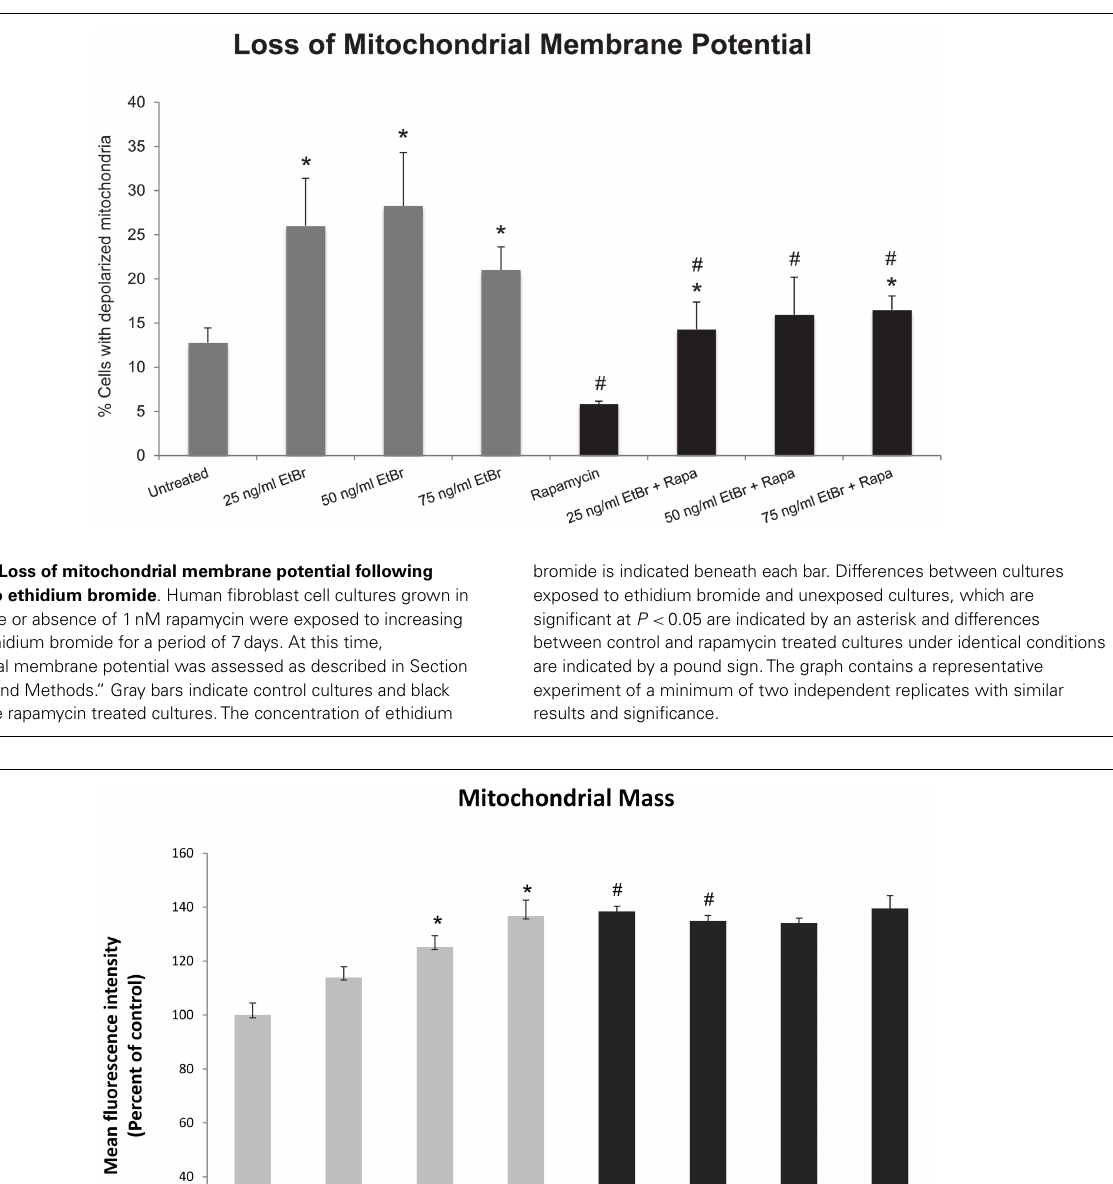
concentration of ethidium bromide is indicated beneath each bar. Differences between cultures exposed to ethidium bromide and unexposed cultures, which are significant at P < 0.05 are indicated by an asterisk and differences between control and rapamycin treated cultures under identical conditions are indicated by a pound sign.The graph contains a representative experiment of a minimum of two independent replicates with similar results and